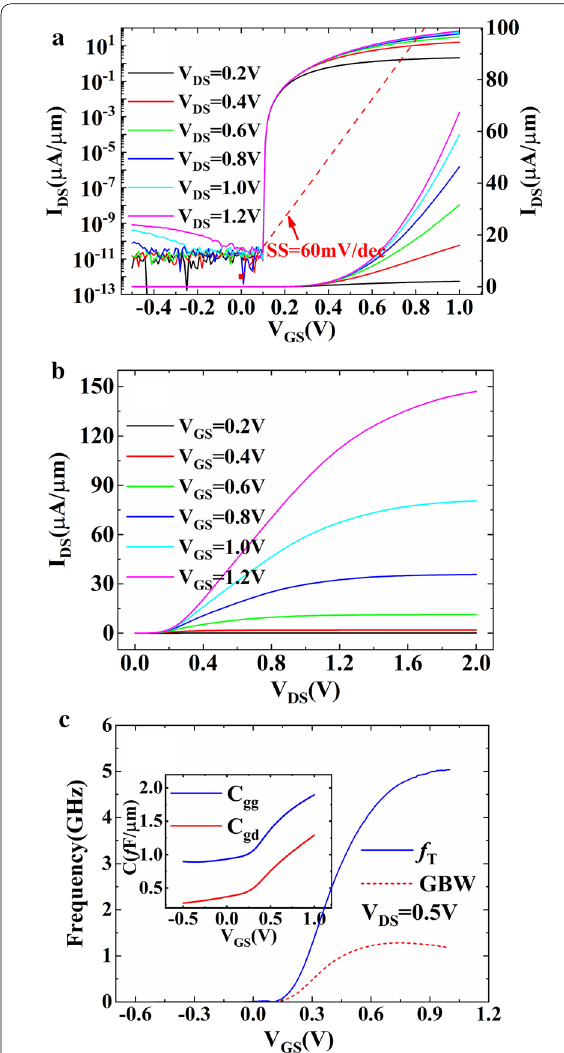
Fig. 5 a Input, b output and c radio frequency characteristics of DF-TFET